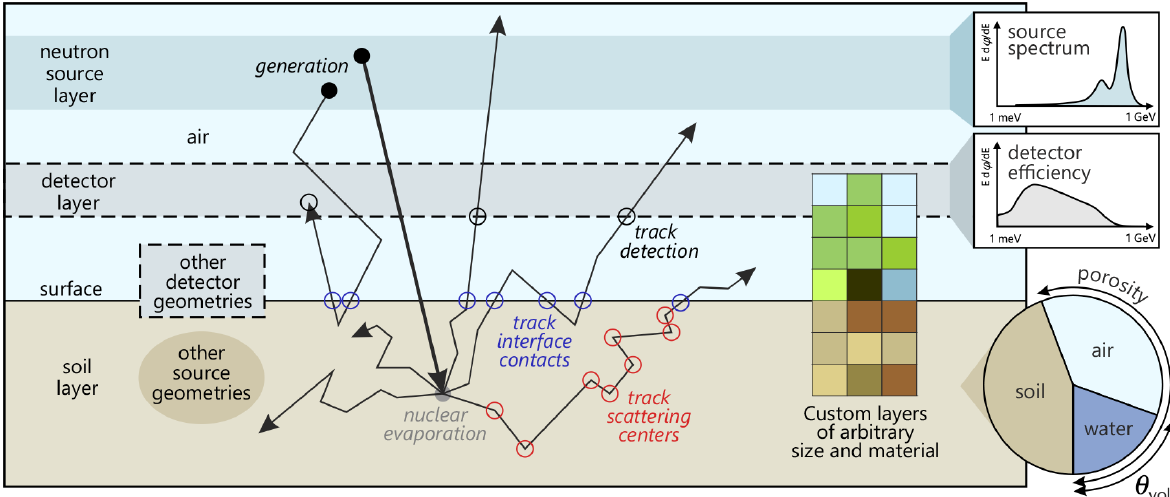
Figure 1. Two-dimensional representation of the three-dimensional model setup (not to scale) and processes. Neutrons are generated in a source layer (black-filled circle) following a source spectrum that resembles the energy distribution of particles propagated through the air column above. High-energy neutrons create fast neutrons by nuclear evaporation in the soil (gray-filled circle). They further scatter within (empty red circle) or through the material layers (empty blue circle) until they eventually reach the detector layer (empty gray circle) which absorbs the neutrons depending on the chosen detector response function. While the soil is modeled as a combination of silicate, air and water, various other components of the environment can be modeled with the available material and density options.